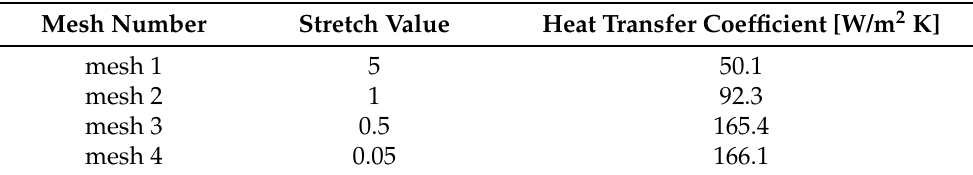
Table 3. Grid refinement analysis for MFiX for Test 2.